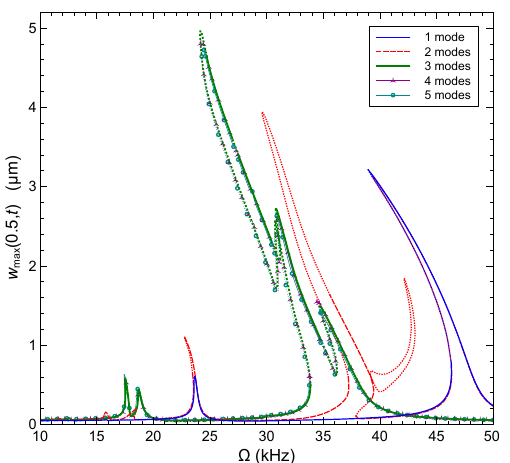
Figure 11. The frequency–response curves obtained using 1–5 mode Galerkin expansions for an arch microbeam with w o = 5µm excited by a half-electrode with the voltage waveform V DC = V AC = 12.2V. Solid and dashed lines denote stable orbits. Dotted lines denote unstable